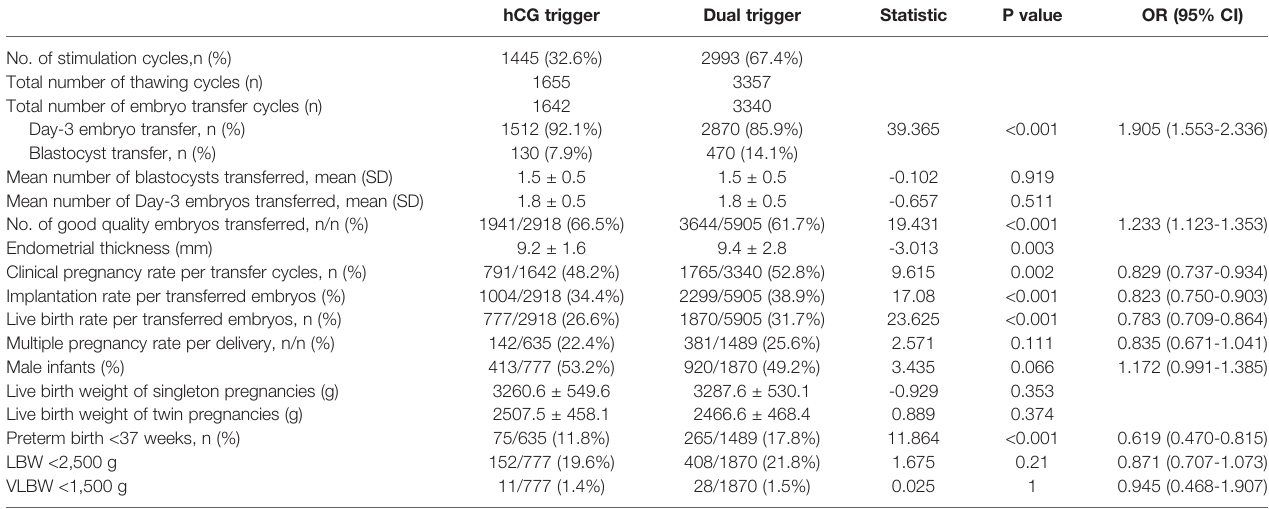
TABLE 2 | Frozen cycle